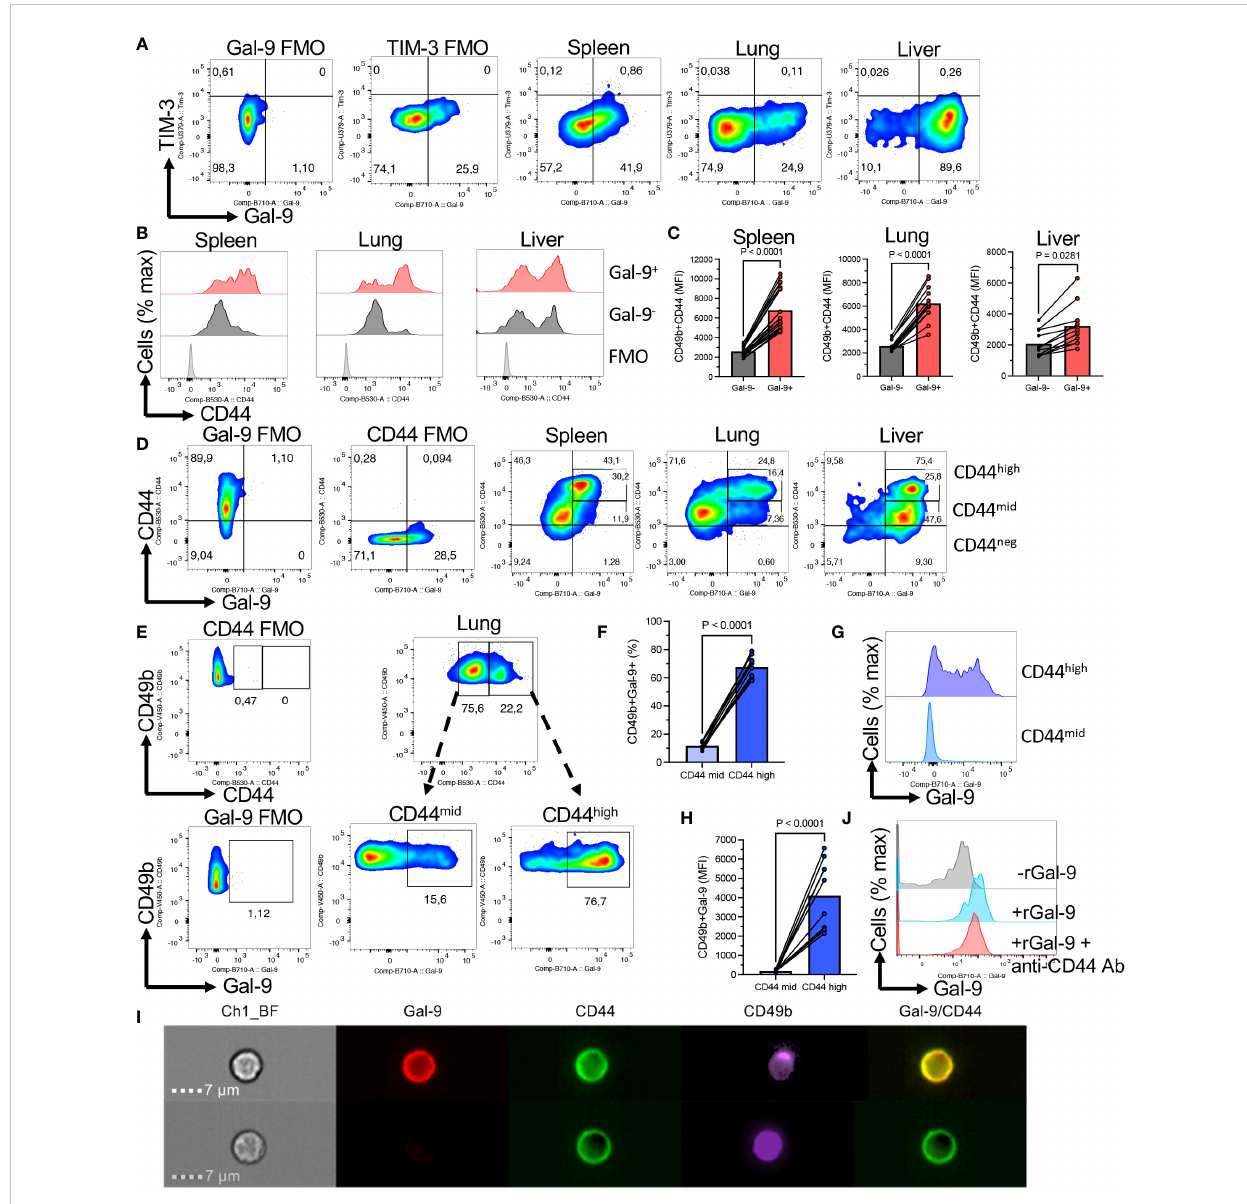
FIGURE 3 Gal-9 is preferentially co-expressed with CD44 high NK cells. (A) Representative fl ow cytometry plots of the expression of TIM-3 in NK cells from the spleen, lung, and liver of adult BALB/c mice. (B) Representative histogram plots, and (C) cumulative data showing the intensity of CD44 expression as measured by the MFI in Gal-9 + and Gal-9 - NK cells from the spleen, lung, and liver of adult BALB/c mice. (D) Representative fl ow cytometry plots showing CD44 and Gal-9 co-expression in NK cells from the spleen, lung, and liver of adult BALB/c mice. (E) Representative fl ow cytometry plots, and (F) cumulative data illustrating percentages of Gal-9 + NK cells in CD44 high and CD44 mid subpopulation of NK cells in the lung. (G) Representative histogram plots, and (H) cumulative data illustrating the intensity of Gal-9 expression in CD44 high and CD44 mid subpopulation of NK cells in the lung. (I) Representative Image Stream plots showing Gal-9 and CD44 co-localization on a CD49b cell (NK cell). (J) Histogram plots of Gal-9 expression in NK cells from a spleen of BALB/c mouse in the absence or presence of rGal-9 (0.25 m g/ml) and/or anti-CD44 antibody. Each dot represents data from an animal, mean ± SEM from multiple independent experiments. Fluorescence minus one (FMO). Chanel 1 bright fi eld (Ch1-BF). The subdivision gates in Figure 3D cover some of the cells between gates and as result, the quadrant total for the liver is higher (75.4%) than the sum of 25.8% + 47.6%